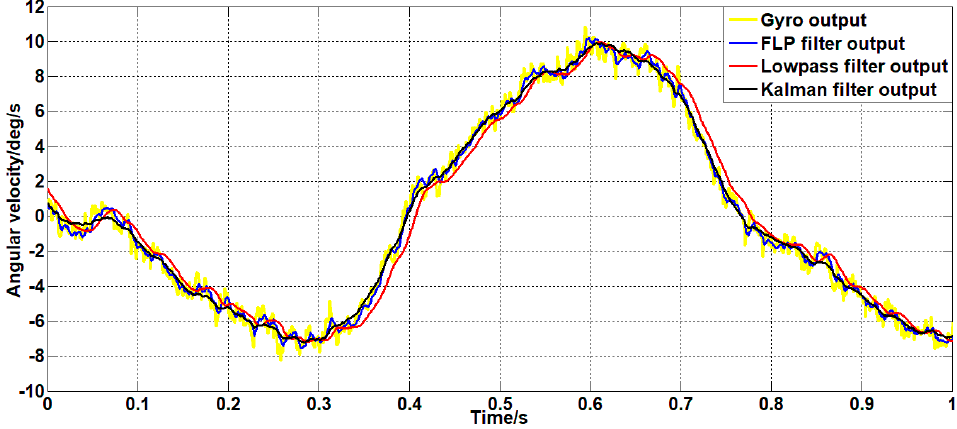
ff erent filtering Figure 23. Comparison of response speeds of different filtering algorithms. Figure 23. Comparison of response speeds of di Figure 23. Comparison of response speeds of different filtering algorithms.